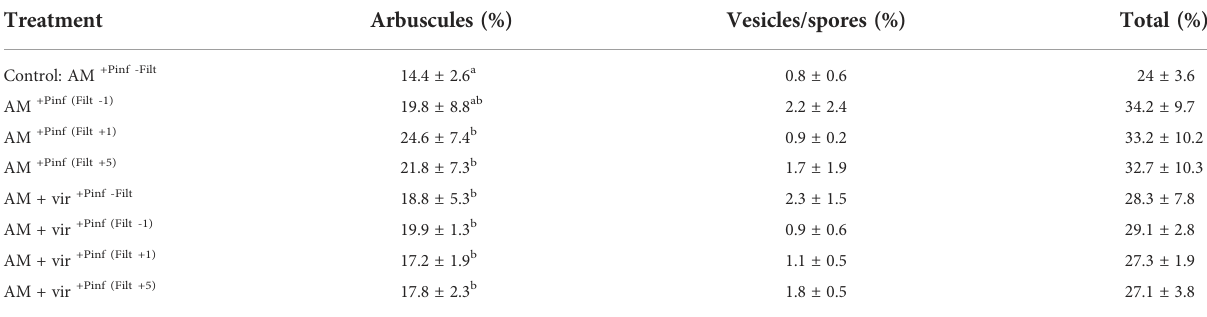
TABLE 3 Percentages of arbuscules, intraradical vesicles/spores, and total colonization of roots of potato plants grown under greenhouse conditions after 10 weeks of association with R. irregularis MUCL 41833 propagules, entrapped (AM + vir) or not with a culture fi ltrate of T. virens